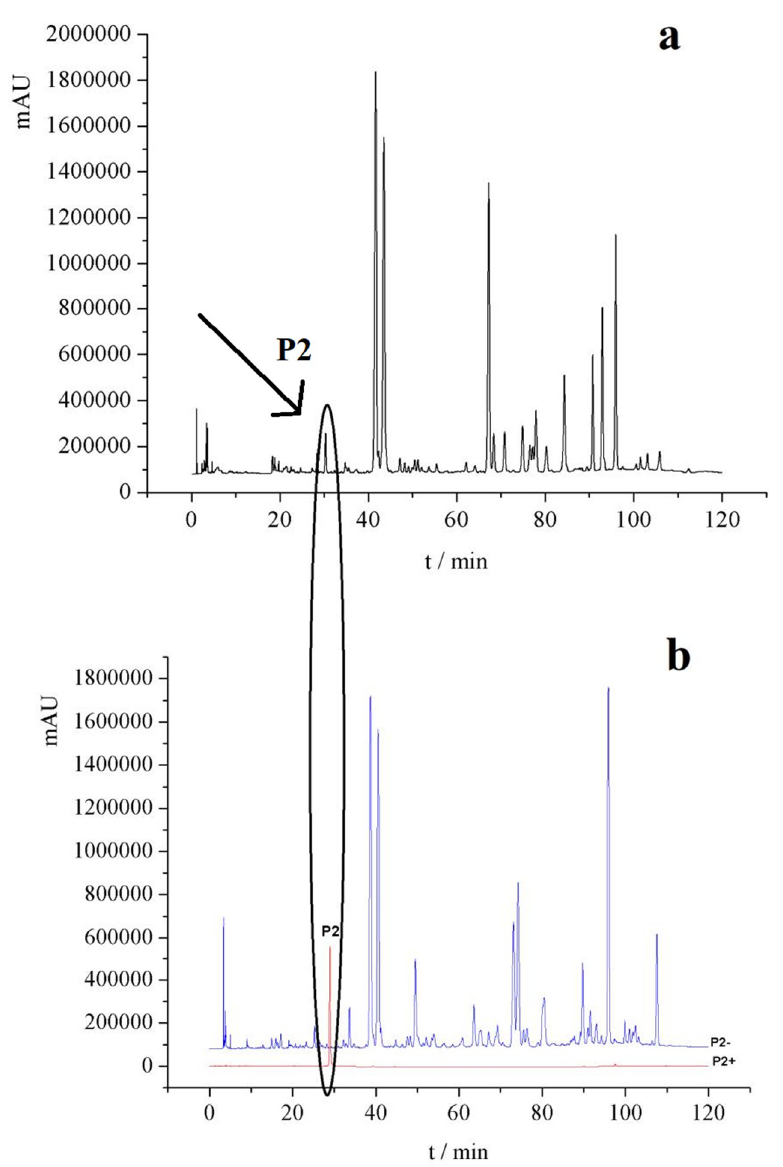
Figure 3. ( a ) HPLC chromatogram of ethanol extract of P. corylifolia ; ( b ) A component (Px + ) and negative samples (Px −